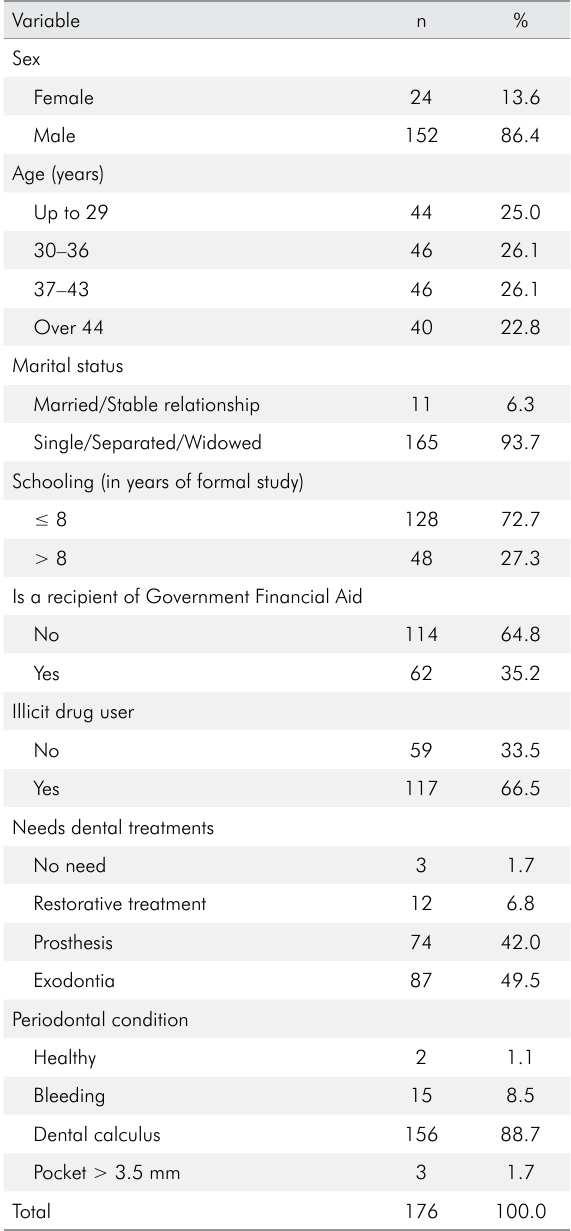
Table 1. Sociodemographic and oral health-related data of the homeless participants of the study (n =